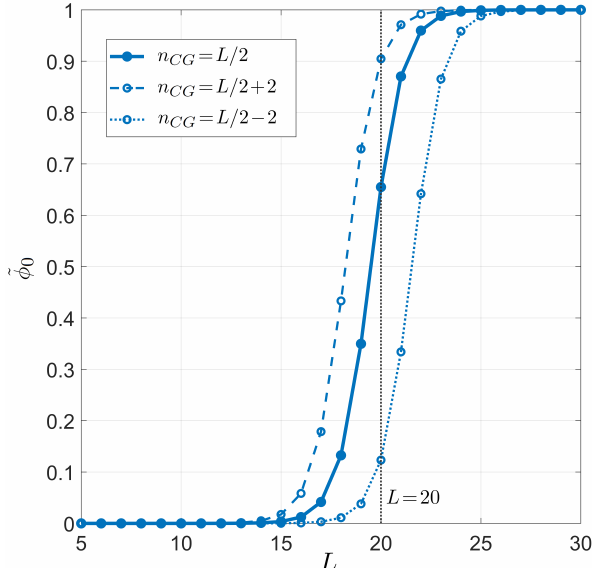
Figure 4. Dependence on the primer length L of the on-target pairing probability conditioned on the well-paired 3 (cid:48) end for PCR. Fixed values are considered for temperature T = 55 ◦ C, salt concentration [ Na + ] = 55 mM, and total sites L = 6 × 10 9 , for different CG fractions in the primer. Full dots and 0 solid line: CG fraction n CG = L /2. Open dots and dashed line: CG fraction n CG = L /2 + 2. Open dots and dotted line: CG fraction n CG = L /2 − 2. Curves are computed using the average energetic description, detailed on the CG fraction (Equations (11) and (12)). The vertical gray line stands for L = 20, a typical primer length in